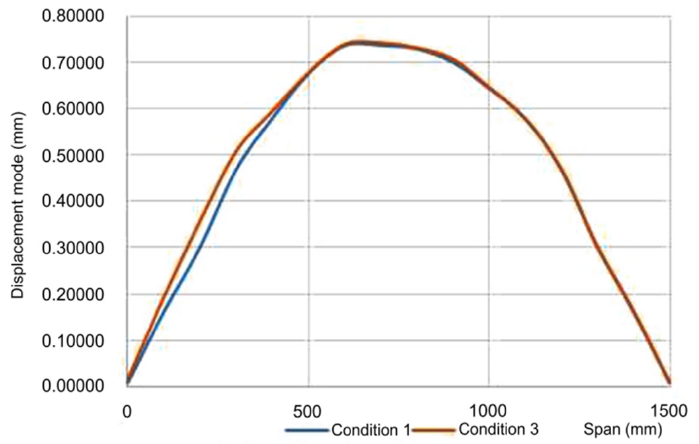
( e ) Comparison of the fifth-order vibration modes under Conditions 1 and 2. Figure 9. Comparison of first five orders of vibration modes under Conditions 1 and 2. The comparison graphs of displacement modes under Condition 1 (single-span non- damaged) and Condition 3 (damage at the 1/4 position), as shown in Figure 10.